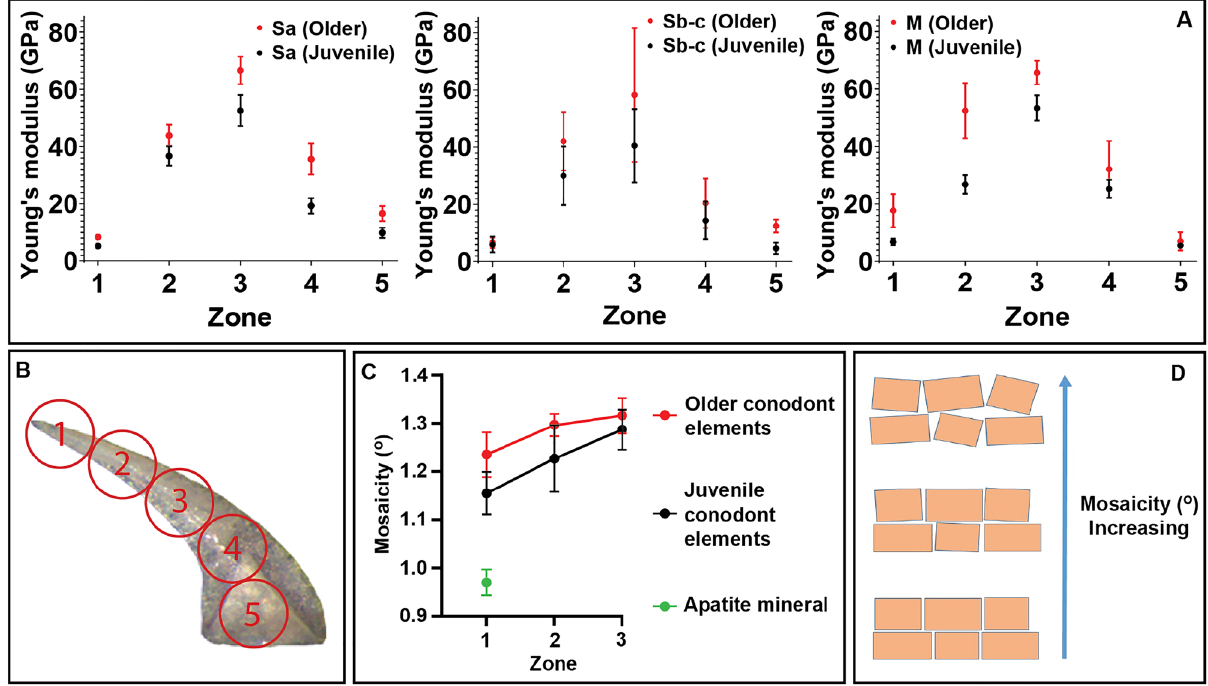
Figure 2. ( A ) Young’s modulus (average and one standard deviation) by element type and position along each element. ( B ) Measurements taken along the length (oral to aboral, 1 through 5, respectively). ( C ) Mosaicity along the length of elements in zones 1–3. Mosaicity can only be calculated in those areas exhibiting single crystal diffraction patterns 21 and is a measure of nanocrystallite disordering ( D ) where more orderly arrangements have a lower mosaicity value. Comparing ( A ) and ( C ) there is a clear correlation between increasing mosaicity and increasing Young’s modulus as well as consistency between juvenile and older